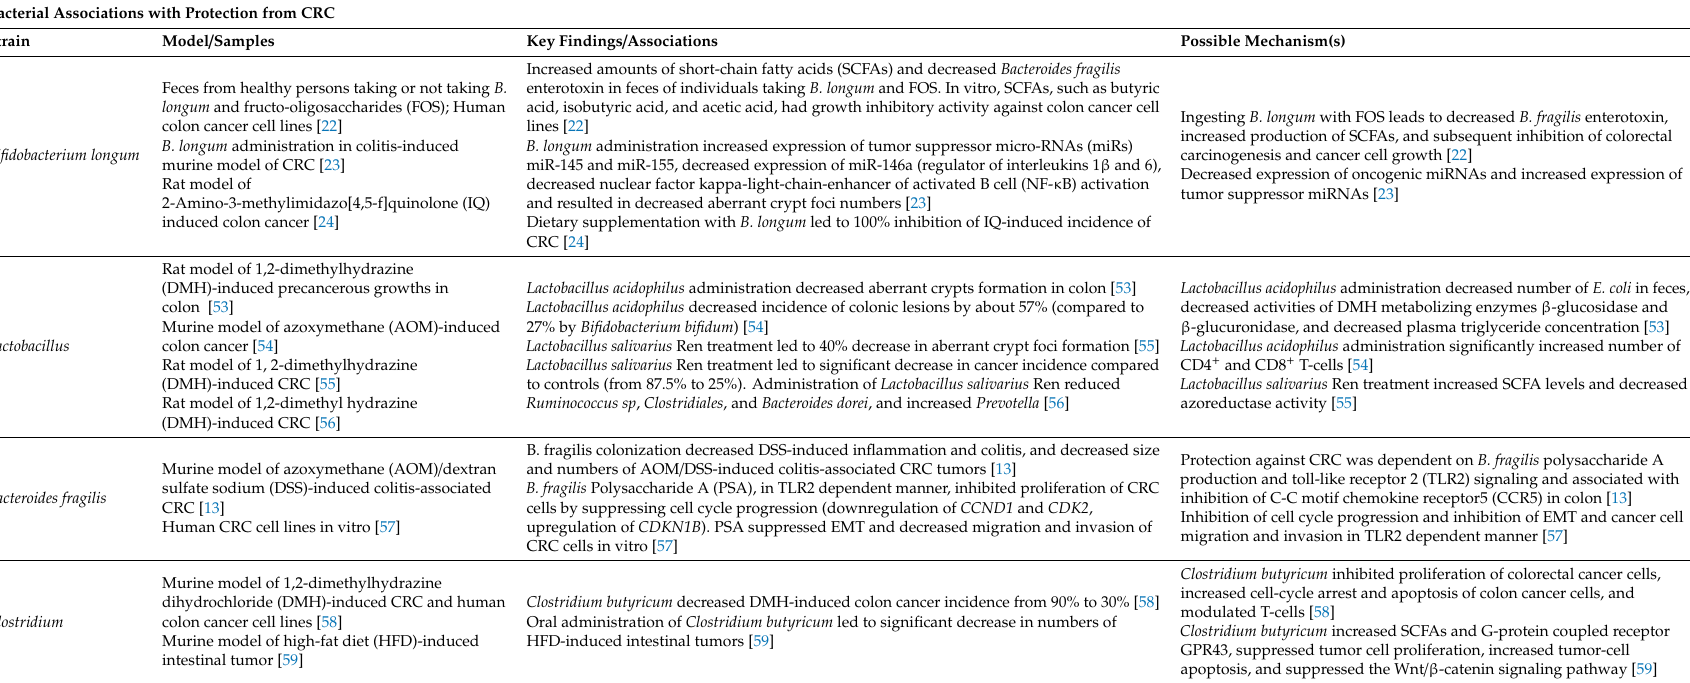
Table 2. Summary of bacterial associations with protection from